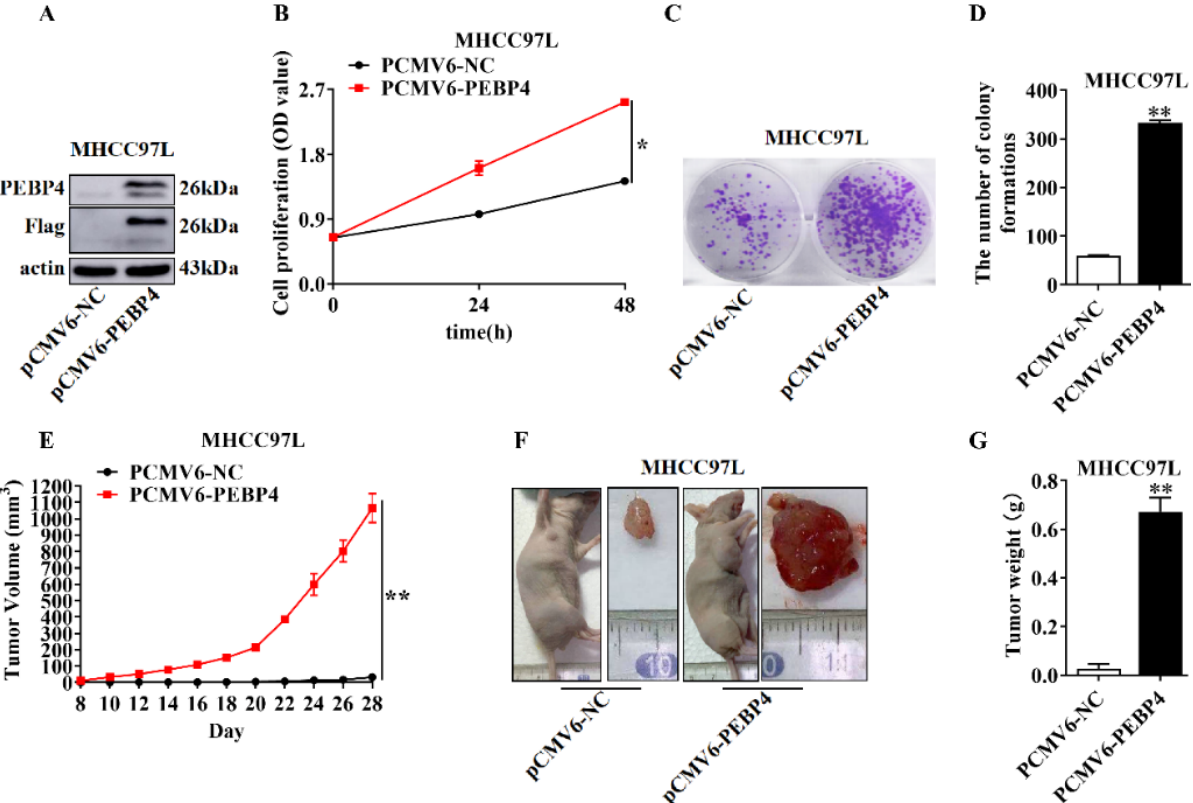
Figure 5. Overexpression of PEBP4 promotes the growth of HCC. ( A ) MHCC97L cells were trans- fected with pCMV6-PEBP4 or pCMV6-NC (empty vector) and then examined by WB. ( B ) Cell pro- liferation. ( C ) Colony formation. Colonies in triplicate were counted ( D ). ( E ) BALB/C nude mice (n = 5) were injected into right fossa axillaris with the cells indicated in ( A ), and tumor volumes meas- ured. ( F , G ) Mice were sacrificed after 28 days, and tumors were weighed ( G ). Representative images of mice (right fossa axillaris) and isolated tumors ( F ) were presented. Statistical analysis was per- formed as for Figure 4. * p < 0.05, ** p < 0.01.